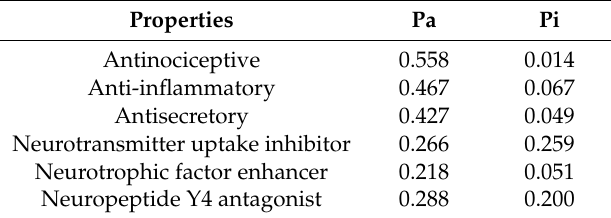
Table 9. PASS prediction of the beta-sitosterol isolated from B. pilosa leaves.